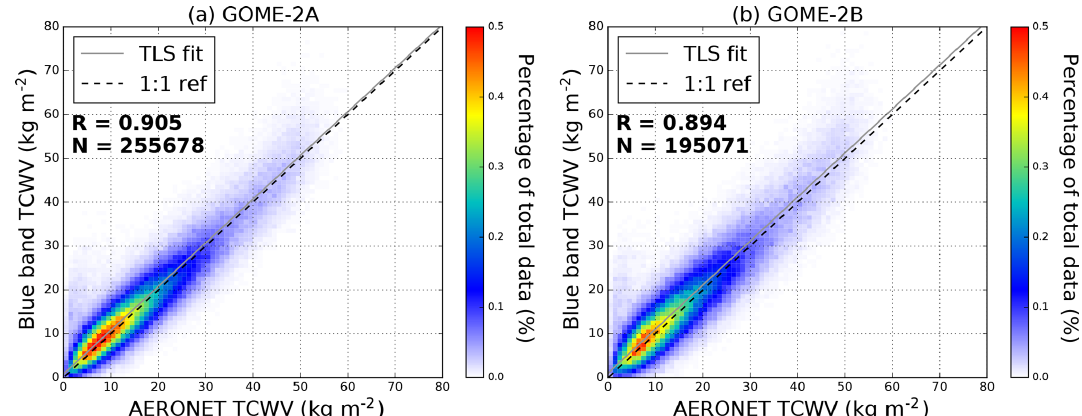
Figure 12. Comparison of the TCWV, measured by the sun photometer, to GOME-2A is shown in (a) , while the comparison to GOME-2B is shown in (b) . Co-located daily averaged data are used in the comparison.